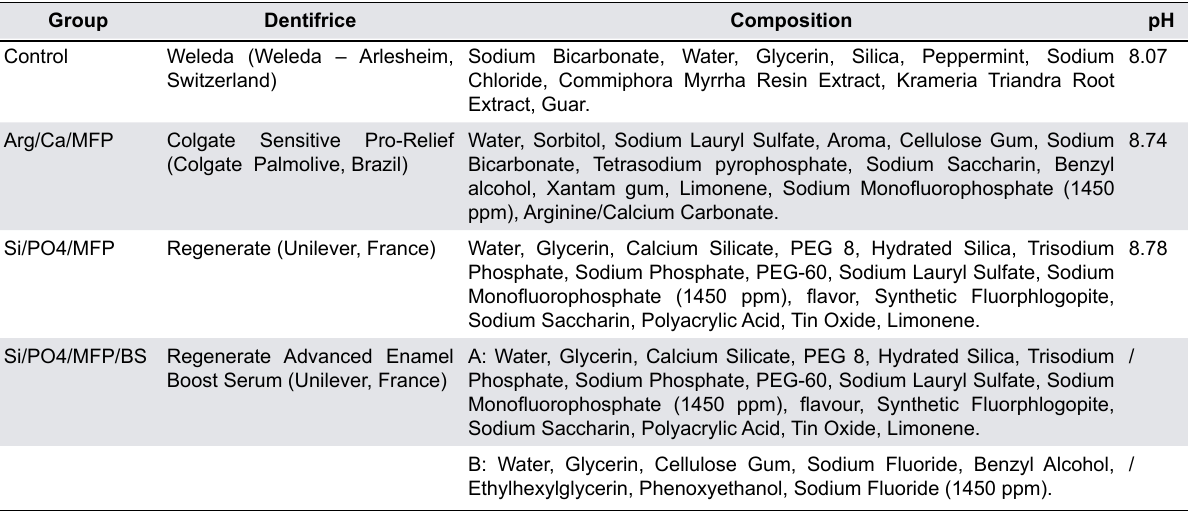
Table 1- The composition of the dentifrices and pH-values for the